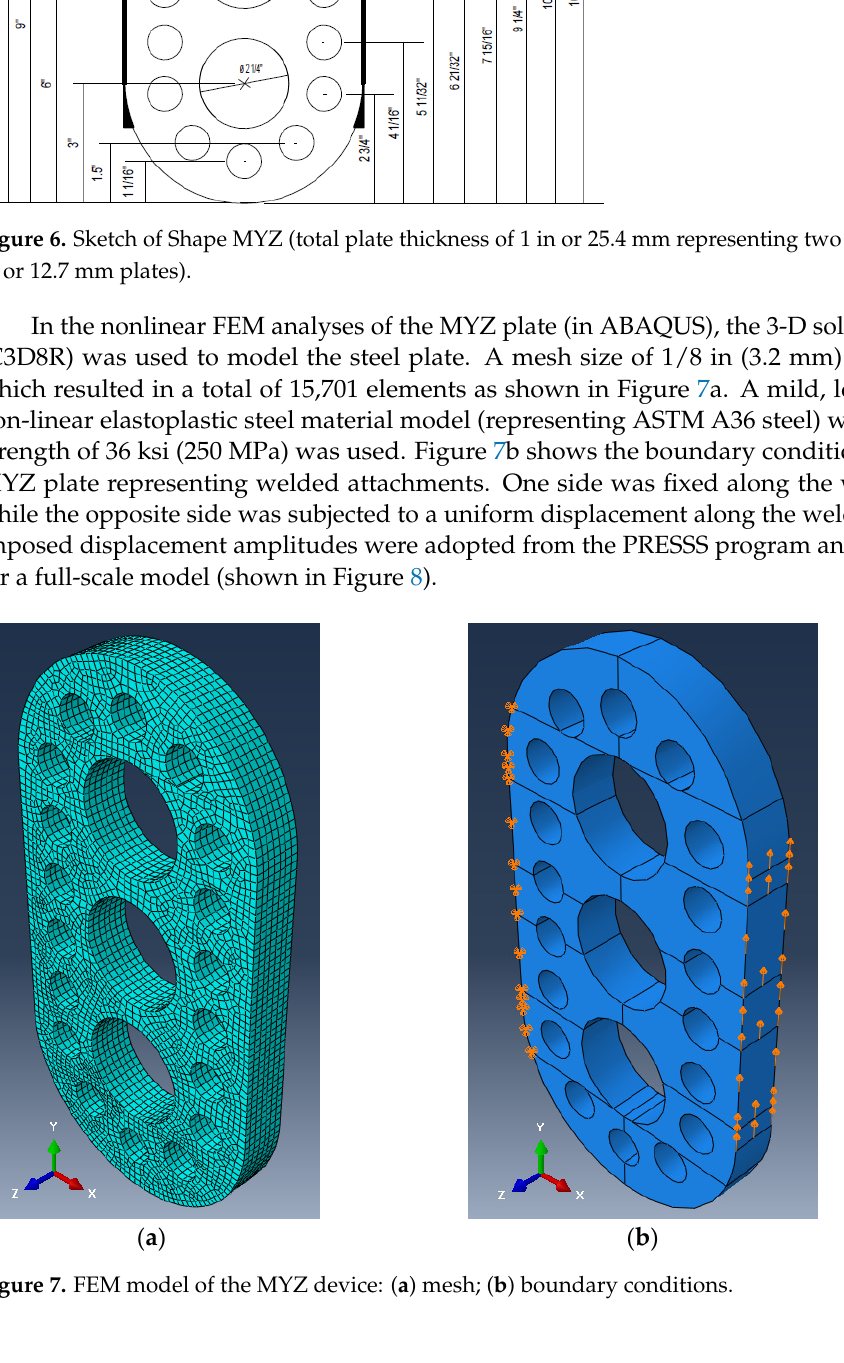
Figure 8. PRESSS displacement cycles for full-size connector tests. Contour maps showing maximum principal plastic strains for the ±2.5 in (64 mm) displacement cycles are shown in Figure 9. As expected, the plastic strains were primarily concentrated in multiple bands between circular openings. Figure 10 shows the force ver- sus vertical displacement graph. This graph shows yielding at relatively small displace- ments and the response exhibits high energy-dissipating hysteretic behavior. The